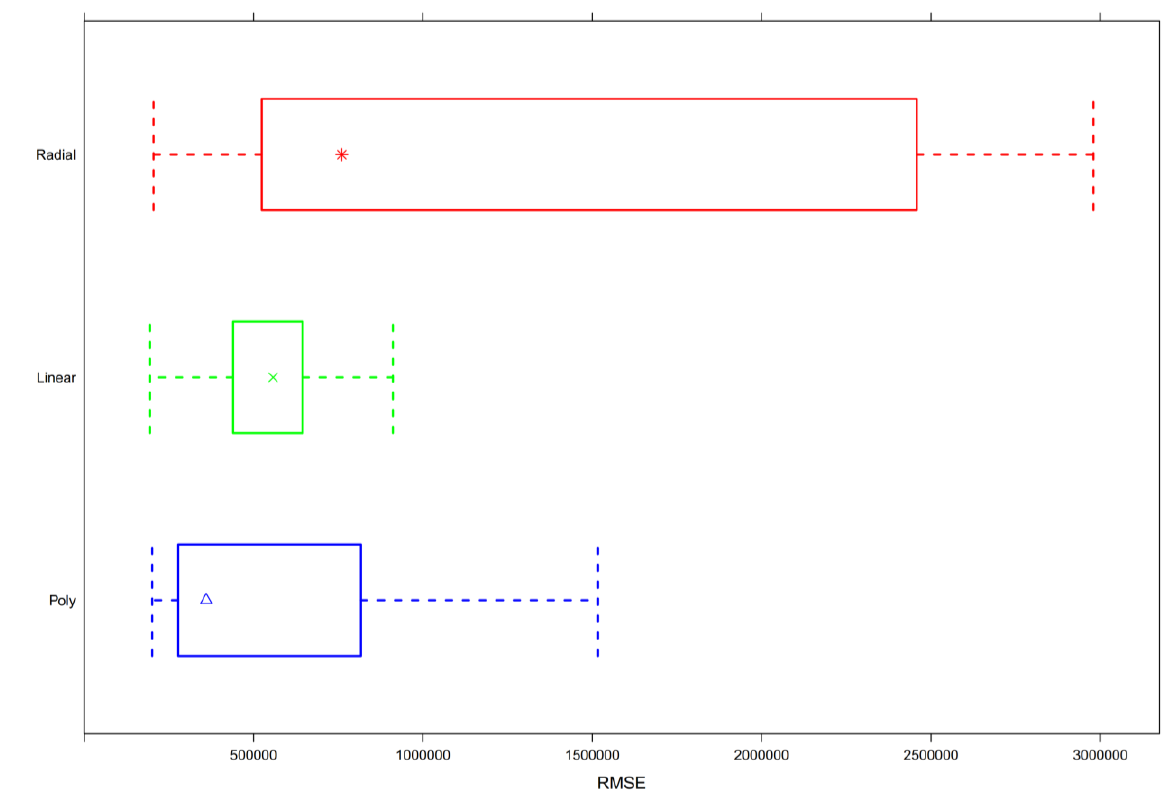
Figure 6. BloxPlot of RMSE for each of the